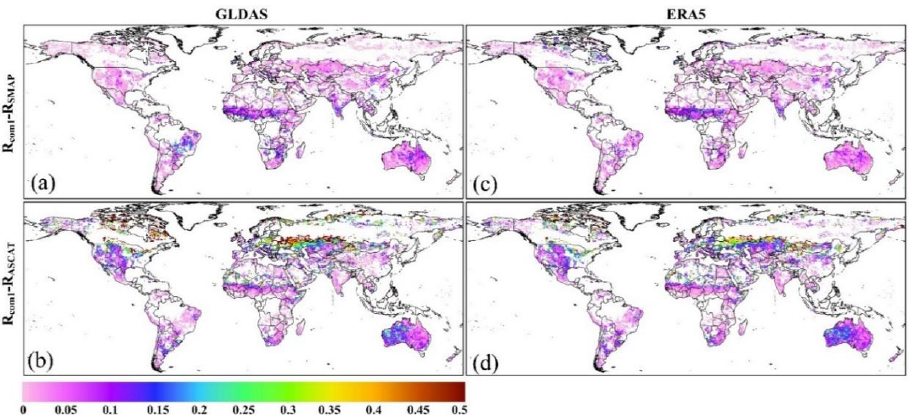
Figure 9. The spatial distribution of differences in correlation coefficients (against modeling datasets) between merged (SMAP+ASCAT) and parent (SMAP and ASCAT) SM datasets, where (Rcom1 minus RSMAP) (first row), (Rcom1 minus RASCAT) (second row): ( a , b ) for GLDAS, and ( c , d ) for ERA5. Note that, com1 refer to SMAP+ASCAT product.